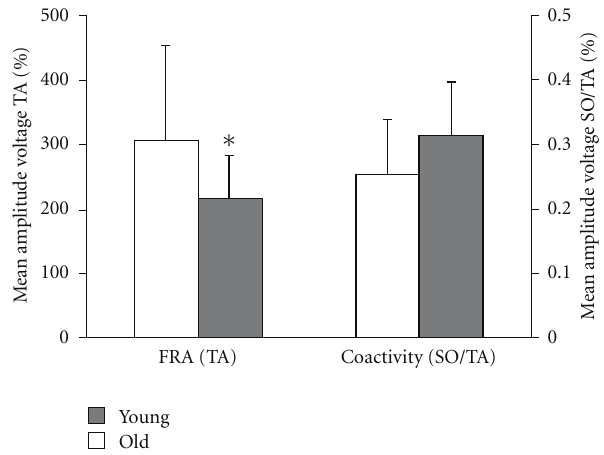
Figure 3: Age-related di ff erences in reactive balance performance (i.e., perturbed walking). FRA: functional reflex activity, SO: m. soleus, TA: m. tibialis anterior. Young di ff erent from old: ∗ P < 0 . 05. Adapted from Granacher et al.